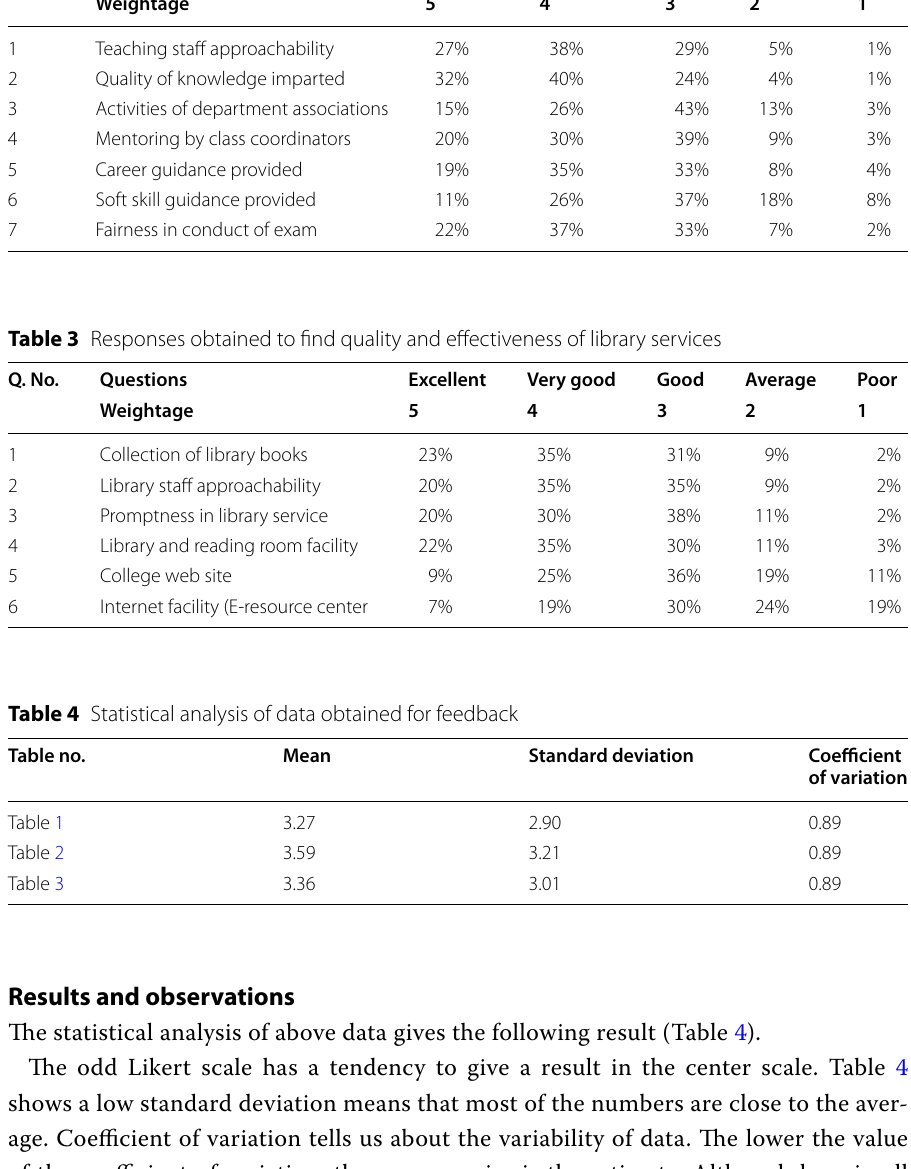
Table 2 Responses to obtained effectiveness of the teachers Q. No.